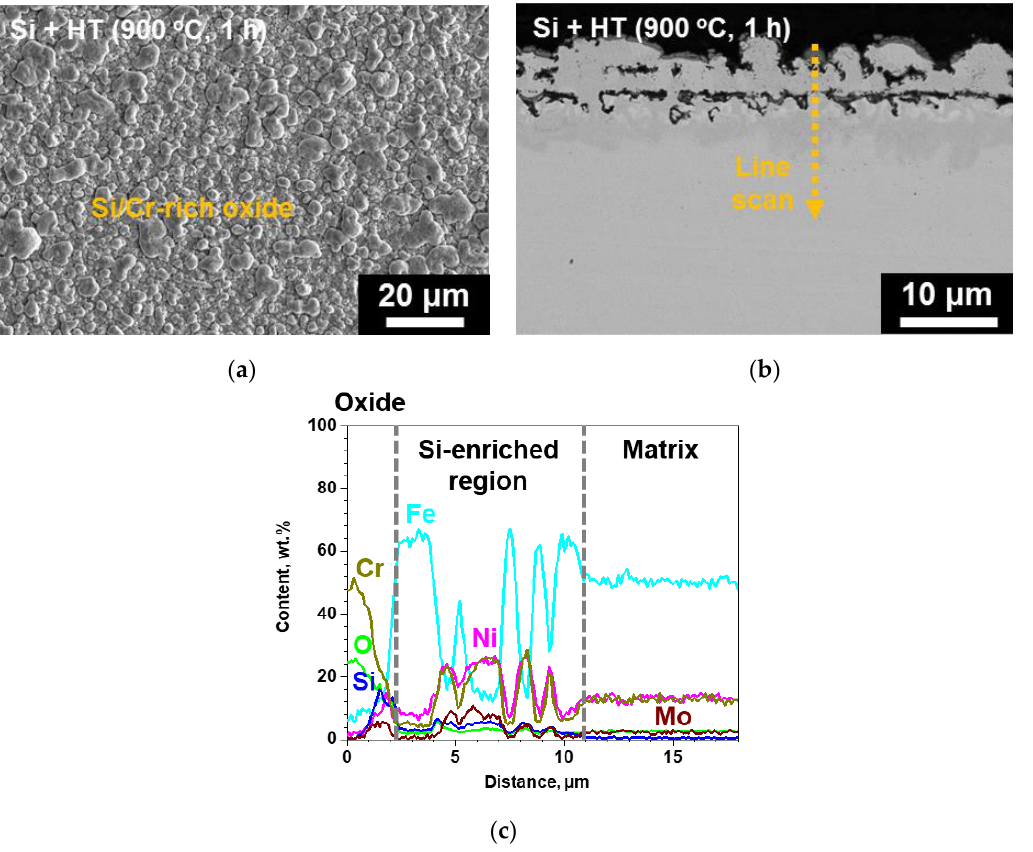
Figure 6. ( a ) Surface SEM, ( b ) cross-sectional BSE micrograph of the surface-modified SS 316LN after exposure to S-CO 2 at 650 o C (20 MPa) for 500 h, and ( c ) result of EDS line scan along the dotted line in (b).